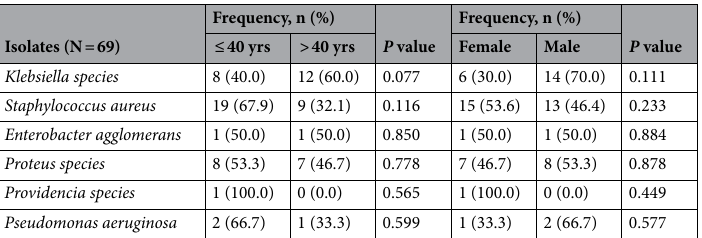
Table 3. Prevalence of pathogens isolated from chronic wound infections according to gender and age group of study participants. yrs: years, n:number.